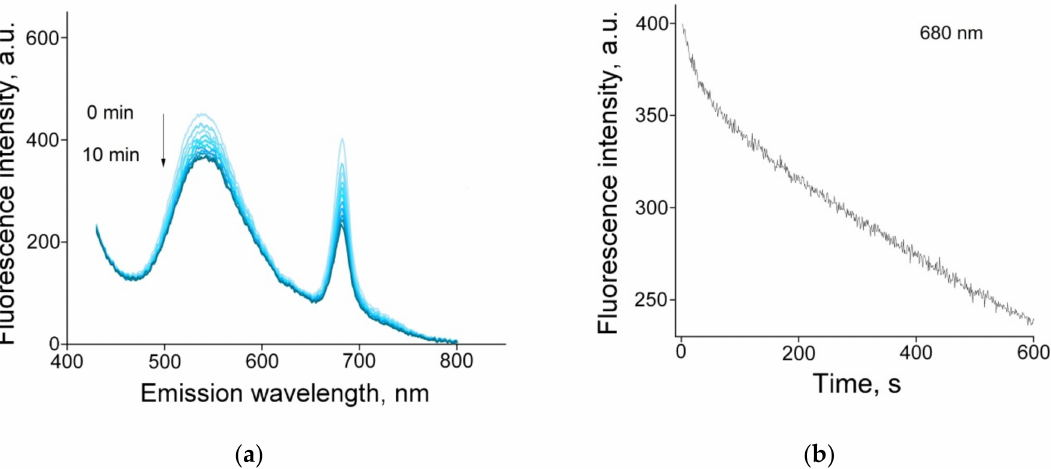
Figure 7. ( a ) Changes in the fluorescence spectra of potato pulp for 10 min; ( b ) fluorescence kinetics of potato pulp at a wavelength of 680 nm for samples with a thickness of 0.5